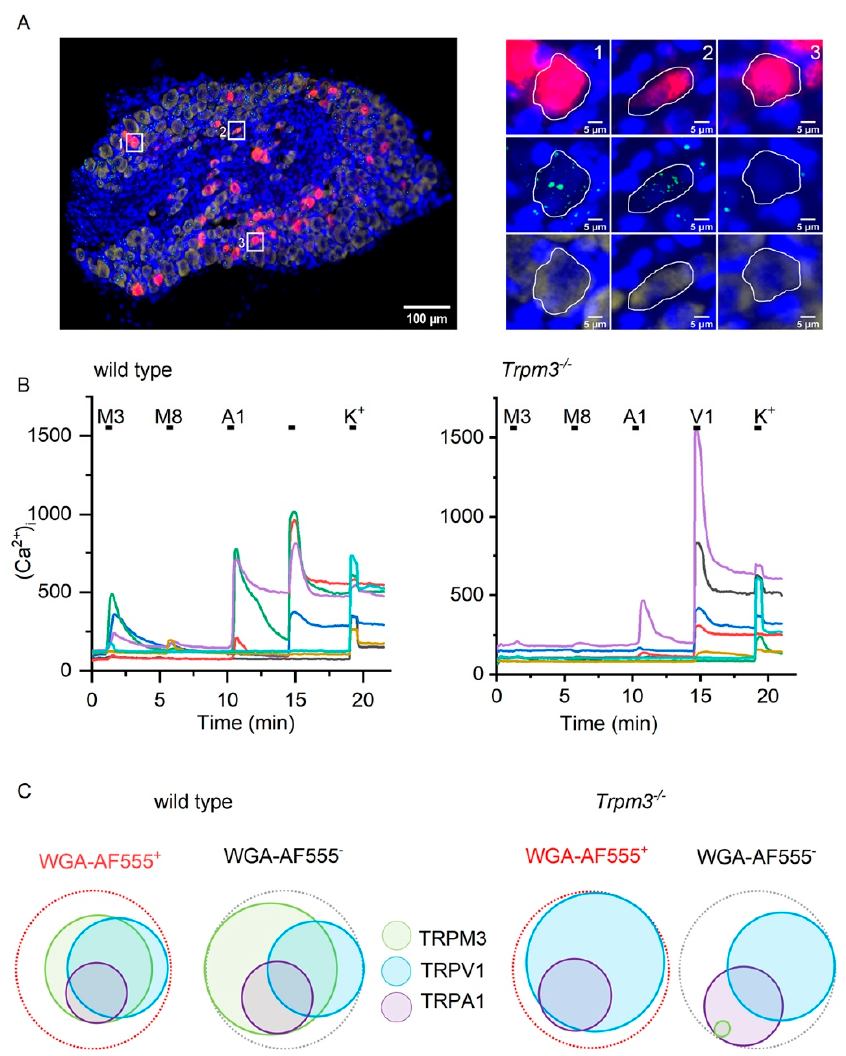
Figure 1. TRPM3 is expressed on bladder afferent neurons. ( A ) RNA in situ hybridization in retrogradely labeled dorsal root ganglion (DRG). Left: DRG stained with WGA-Alexafluor-647 (red), DAPI (blue), Trpm3 (green), and Pgp9.5 (yellow). Scale bar 100 µm. Right: High magnification images of retrogradely labeled neurons (red) expressing Trpm3 (green) and PgP9.5. ( B ) Example traces of wild type (left) and Trpm3 − / − (right) DRG neurons during calcium imaging. Application of agonists for TRPM3 (50 µM pregnenolone sulfate + 2 µM CIM-0216), TRPM8 (100 µM menthol), TRPA1 100 µM (mustard oil), TRPV1 (1 µM capsaicin), and finally a high-potassium solution is indicated above the trace. ( C ) Venn diagrams representing the proportions of wild type and Trpm3 − / − neurons responding to application of agonists for TRPM3 (PS/CIM), TRPV1 (capsaicin), and TRPA1 (mustard oil). Bladder neurons were retrogradely labeled with WGA-AF555. Wild type: n = 2297 neurons from 3 mice, Trpm3 − / − 1625 neurons from 3 mice.